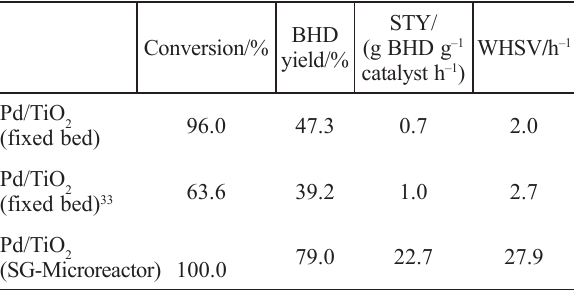
Table 4 – Catalytic activity of Pd/TiO croscale-based